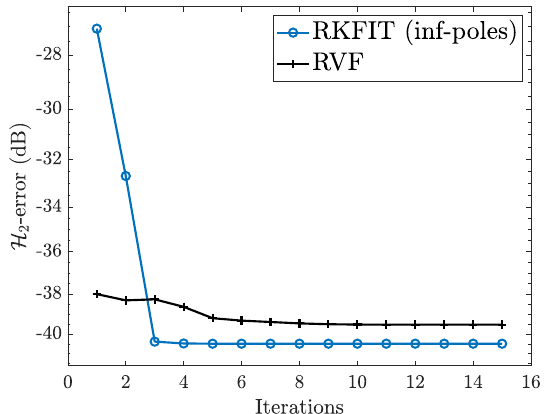
Figure 1. H 2 -error per iteration comparison between RKFIT and RVF algorithms of Section